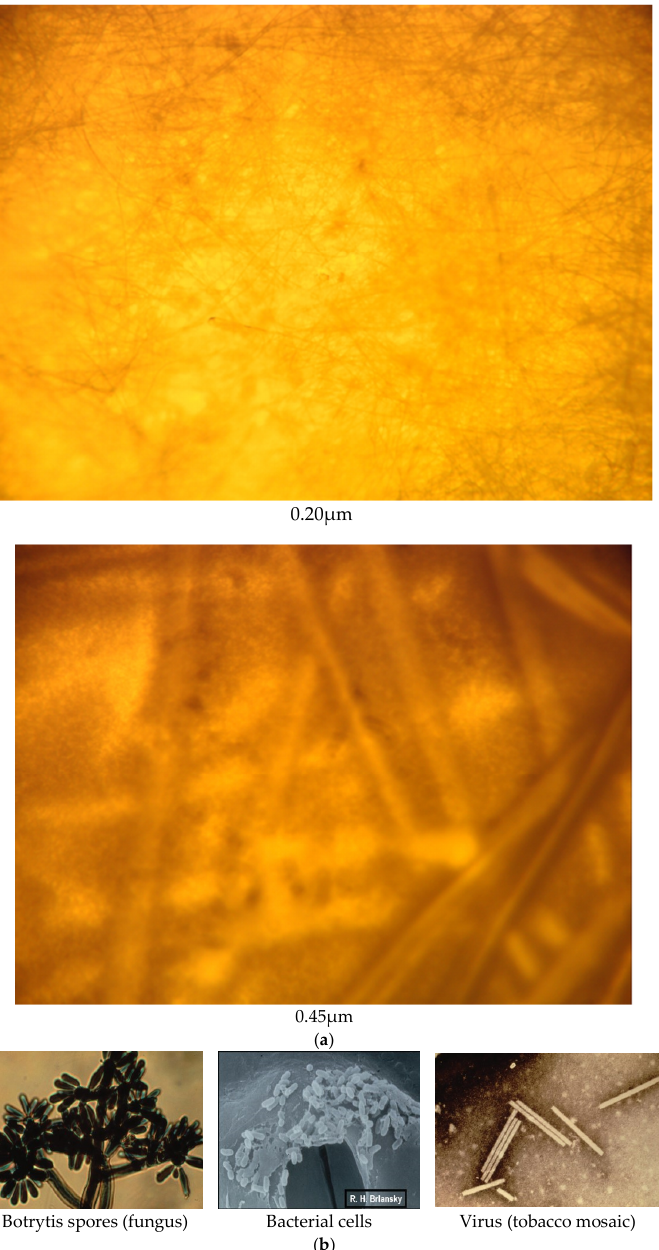
Figure 2. ( a ) Digital microscopic imaging (40×) of filters after GNF filtration. ( b ) Microscopic images of the three pathogens.